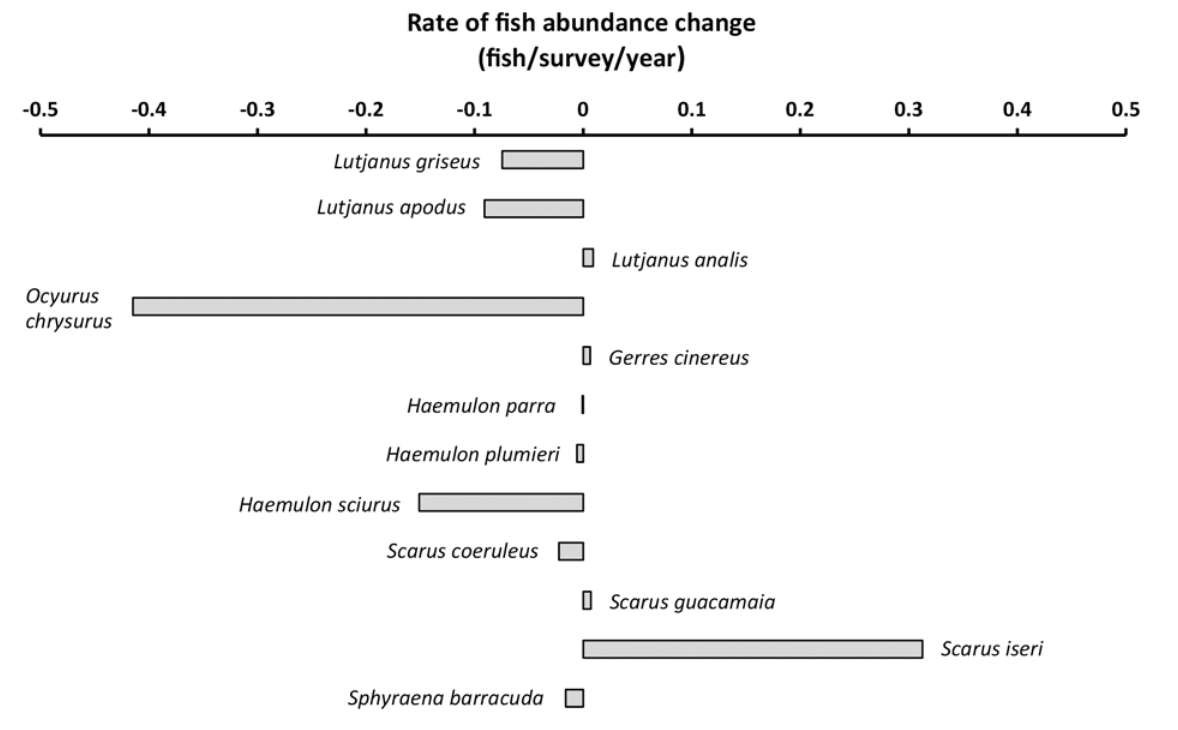
Fig 3. Mean annual rates of change in the abundances on reefs of 12 mangrove-dependent Caribbean fish species. Shown are the coefficients emerging from simple linear regression of the focal species ’ abundances versus year. Negative coefficients indicate decline, positive coefficients indicate increase over the period of record (1993 – 2012). Note that relationships between abundance and time were universally weak ( R 2 values < 0.02).